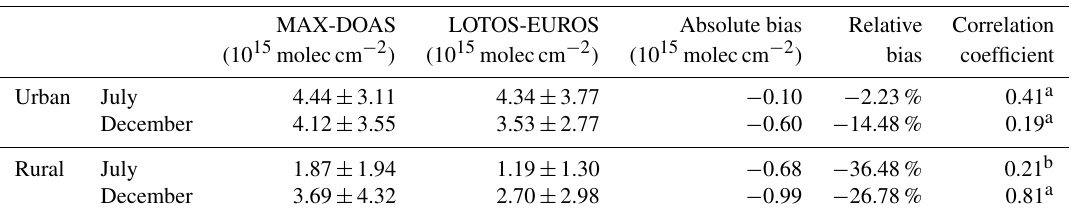
Table 4. Statistics between the MAX-DOAS observations and the LOTOS-EUROS simulations for July and December in Athens at the urban and rural azimuthal directions.